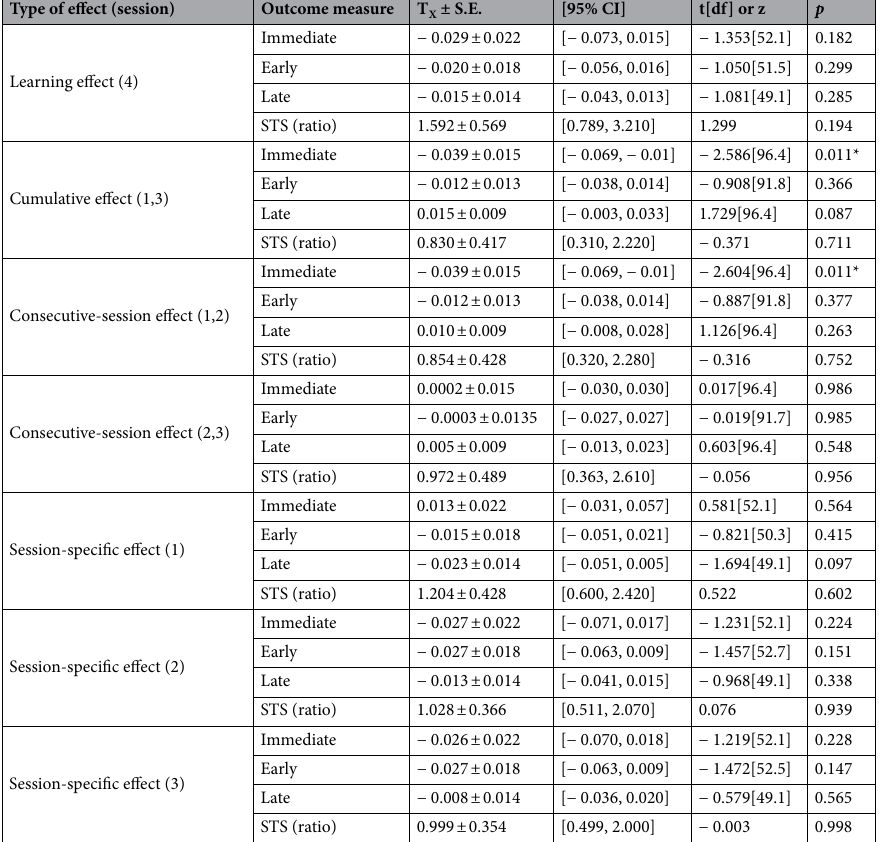
Table 1. Contrast estimates based on marginal means for the adaptation phase treatment effects with the standard errors estimated from the statistical models. STS strides to steady-state, TX treatment effect (in actual units i.e. step length symmetry for immediate, early, and late outcome measures; in ratio for strides to steady- state performance; for example, a ratio effect size of 1.592 means that the experimental group has a 59 percent higher mean value compared to the control group for strides to state-state performance). S.E. standard error, CI confidence interval, t t-statistics, df degrees of freedom, z z-statistics, p p value, * p <